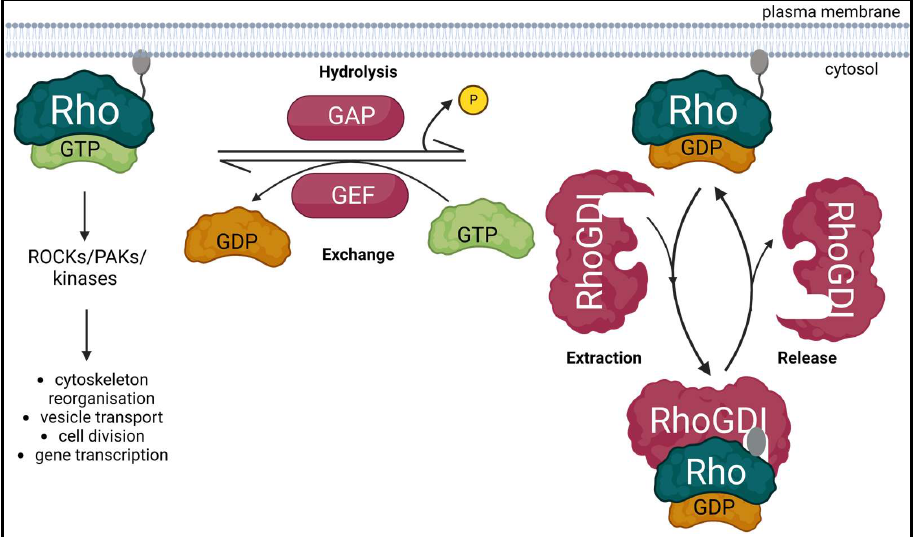
Figure 1. Schematic diagram of the Rho GTPase regulatory cycle. Inactive Rho GTPase is dissociated from its GDP and uptakes GTP to get activated through a process promoted by the Rho guanine exchange factors (RhoGEFs). Active GTP-bound Rho GTPase can then interact with its effectors such as Rho-associated coiled-coil containing kinases (ROCKs), PAK family of serine/threonine kinases (PAKs) and other kinases to participate in various biological processes. This interaction ceases when Rho GTPase-activating proteins (RhoGAPs) stimulate the hydrolysis of the bound GTP to GDP, thereby inactivating the Rho GTPase. The inactive GDP-bound form of Rho GTPase is free to bind to and be sequestered by Rho guanine nucleotide dissociation inhibitors (RhoGDIs). This induces their relocation to the cytoplasm, prevents their ubiquitin-mediated degradation and regulates the activation of Rho GTPases by GEFs. Created with BioRender.com.